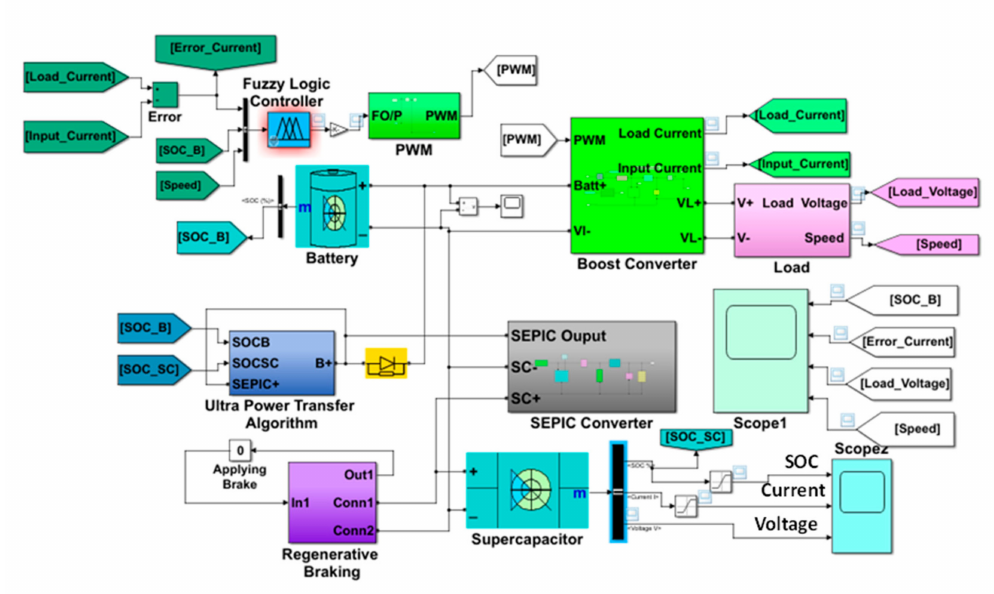
Figure 2. MATLAB simulation of overall proposed